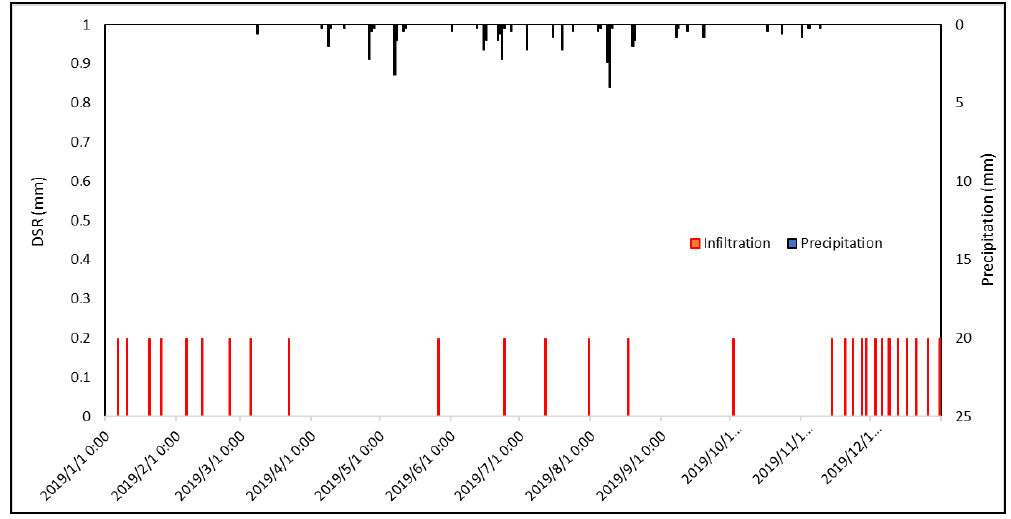
Figure 8. Relationship between precipitation and DSR in 2017.